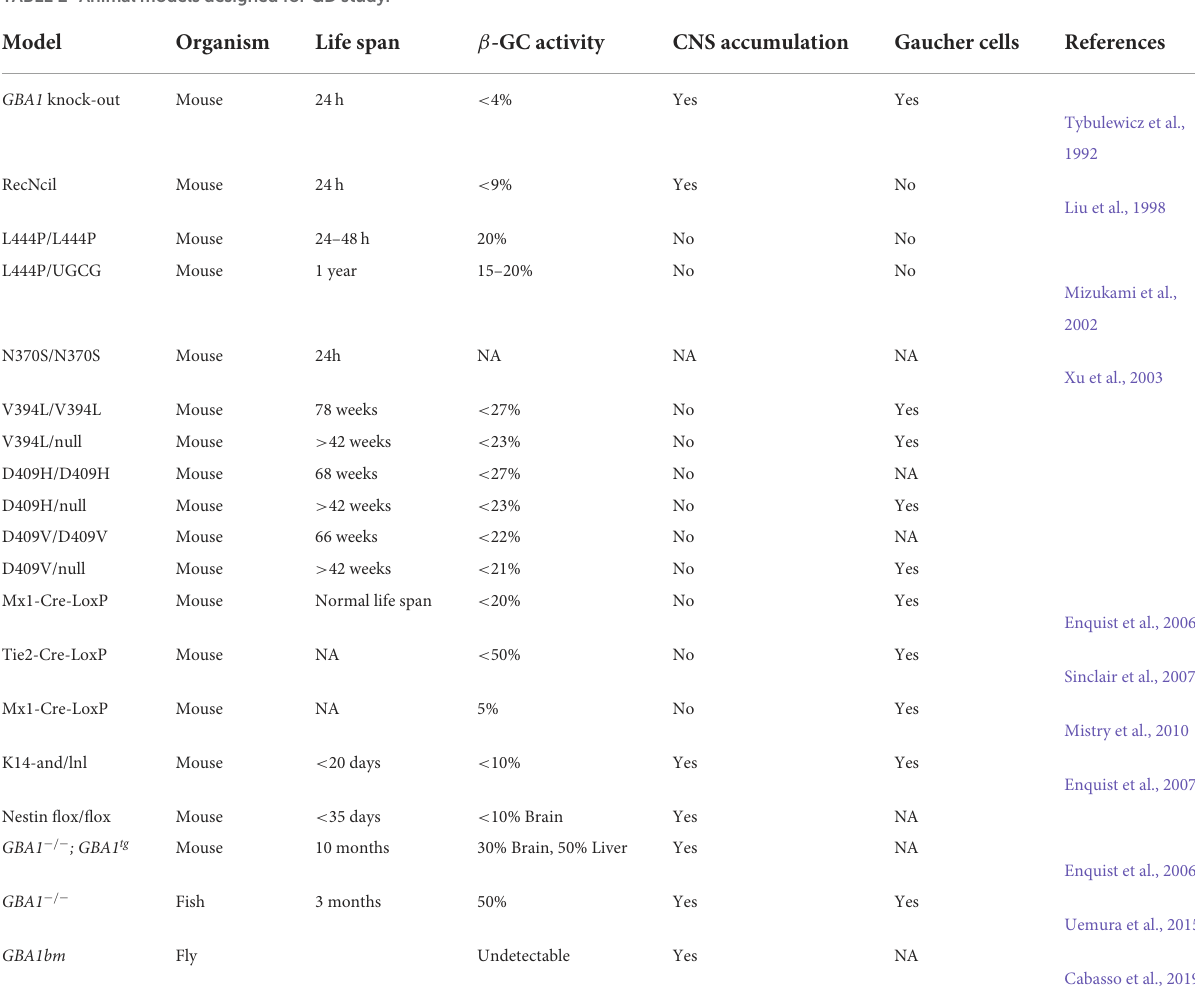
TABLE 2 Animal models designed for GD study.